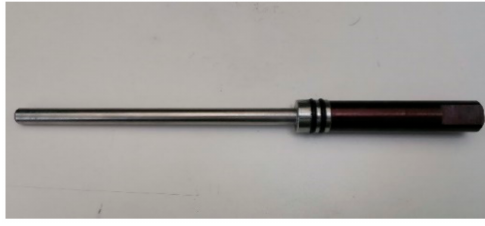
Figure 14. The pin-rod.